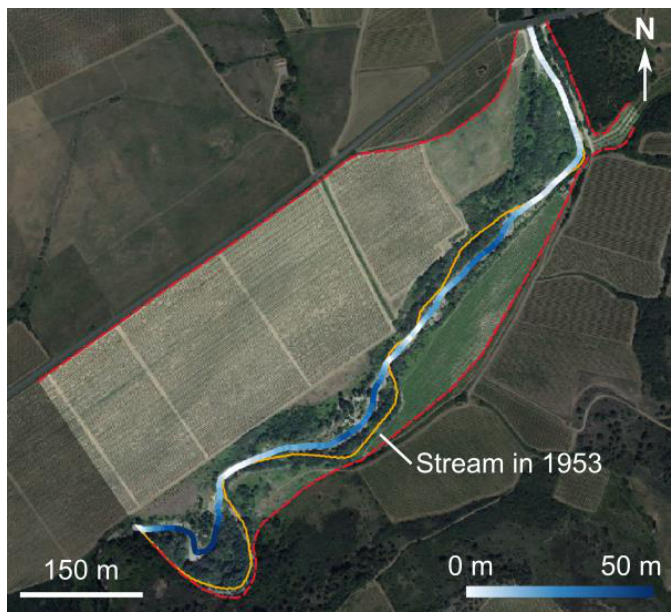
Figure 12. Indicator 3. The distance to the 1953 active channel of the Clamoux River is associated with each point of the 2018 active channel.